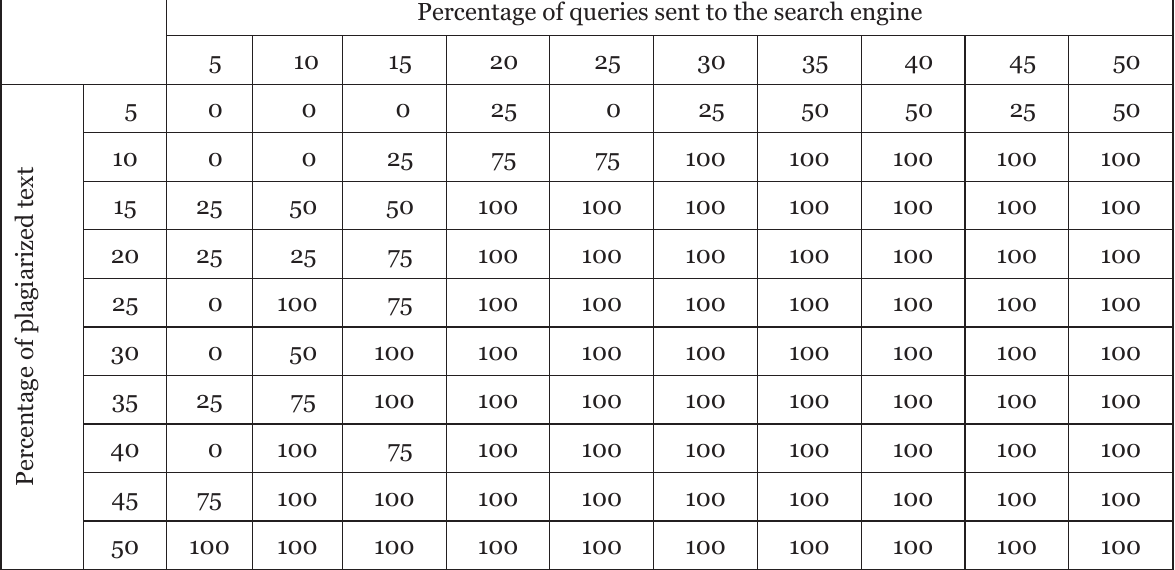
Plagiarism Detection Results for the Objects from a Specialized Domain Category Percentage of queries sent to the search